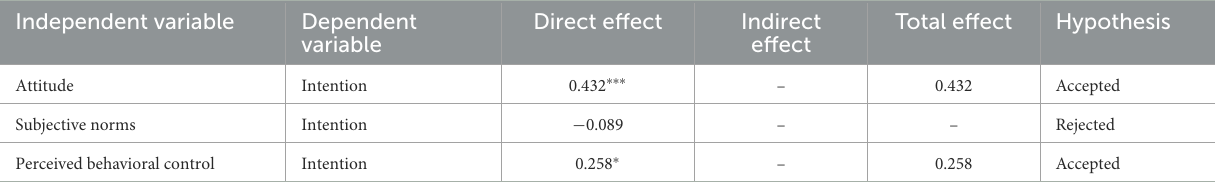
TABLE 6 Total, direct, and indirect effects of constructs on the intention toward the use of injection therapy. Independent